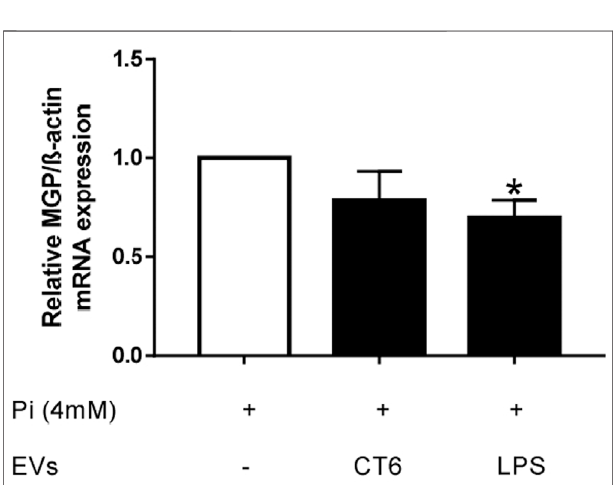
FIGURE13| EV-LPSdecreaseMGPgeneexpressioninsmoothmuscle cells. MOVAS-1 cells were incubated for 7 days with 4 mM Pi with or without EVs secreted by RAW cells. Gene expression of MGP was then quanti fi ed by quantitative real-time PCR and normalized to that of the housekeeping gene ß-actin. Data are expressed as the mean ± SEM of seven independent experiments performed in triplicate ( n = 7). * p < 0.05 vs . 4 mM Pi, Mann- Whitneytest. EV-CT: EVs derivedfrom untreated macrophages, EV-LPS: EVs derived from LPS-EK-treated macrophages.